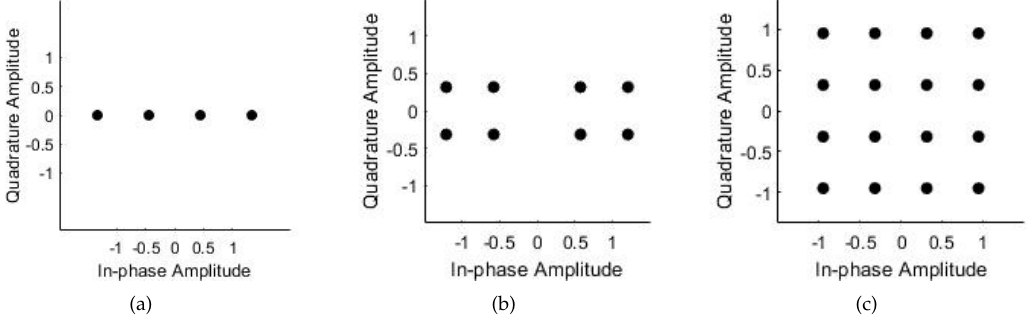
Figure 10. Constellation of UE signal superposition coding: ( a ) BPSK and BPSK, ( b ) BPSK and QPSK, and ( c ) QPSK and QPSK.